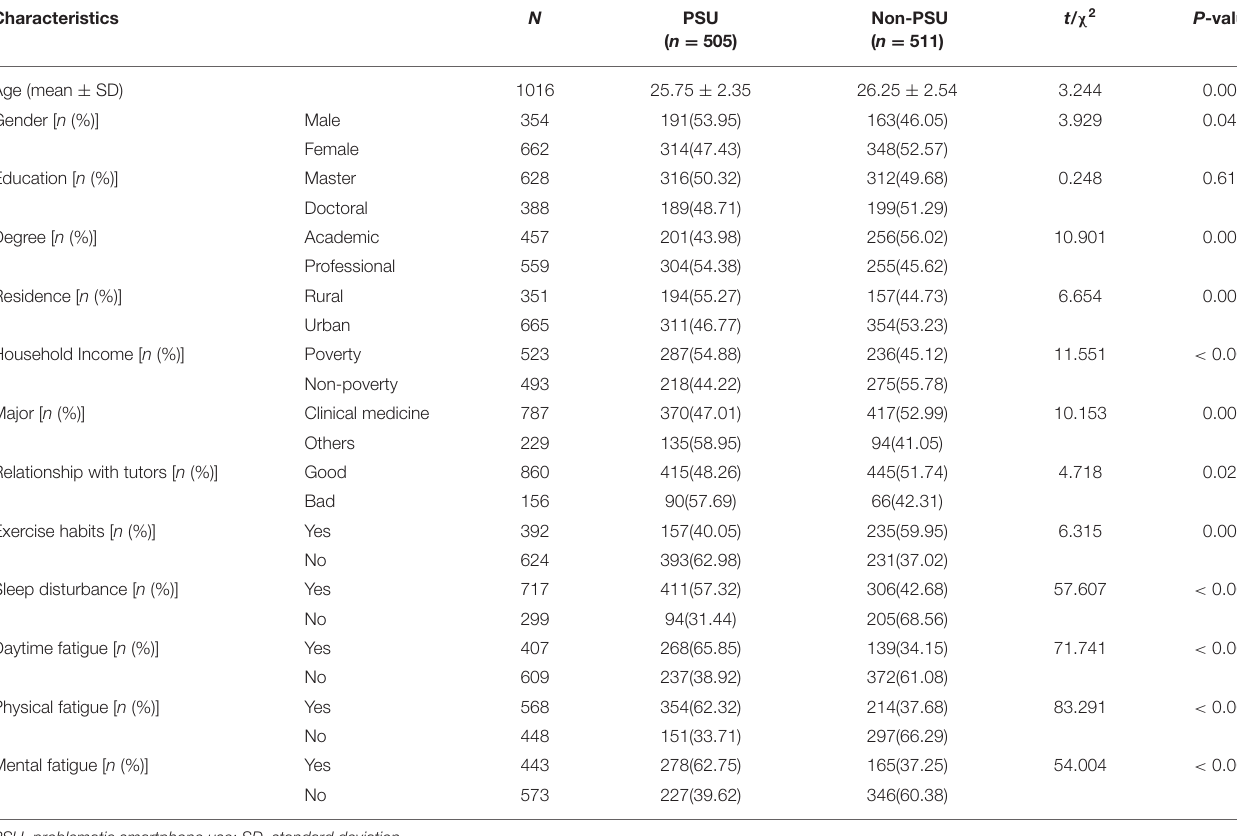
TABLE 1 | Characteristics and PSU status of 1,016 medical students.